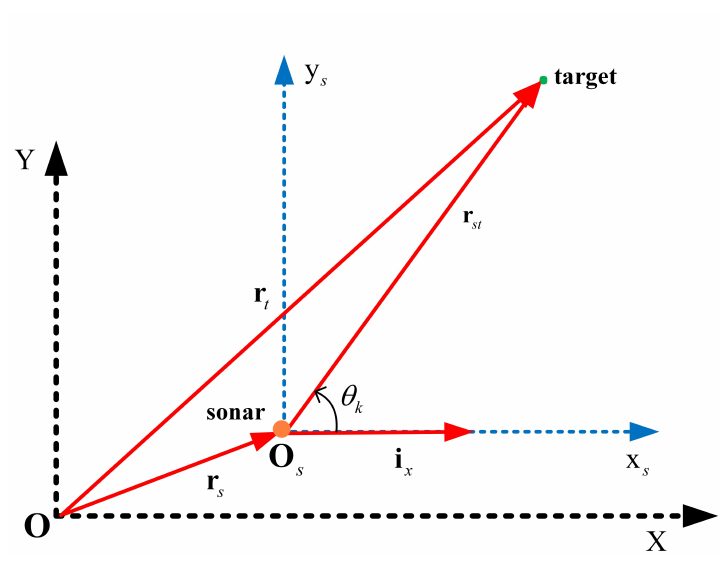
Figure A1. Geometry between the target and BO